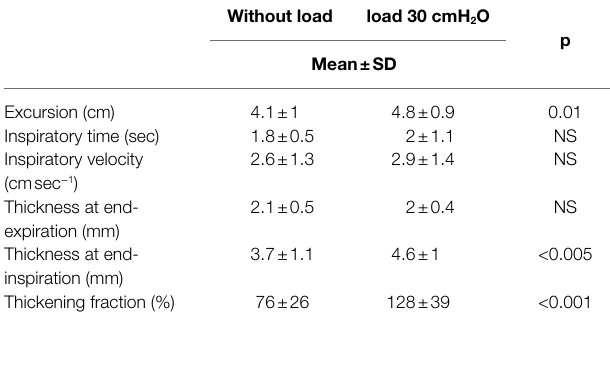
TABLE 2 | Changes in the diaphragmatic parameters induced by a high inspiratory load in volunteers breathing at high volume. Without load